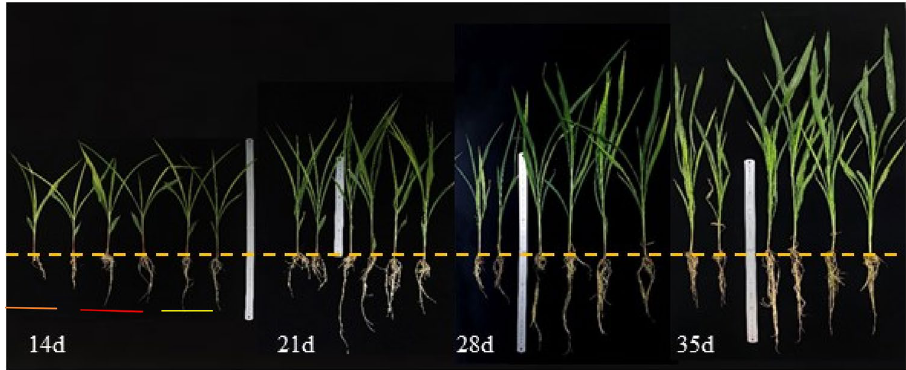
Figure 1. Growth status of maize seedlings in different treatments over time. From left to right different colour line represents maize seedlings of Control, B. bassiana treatment and M. anisopliae treatment,